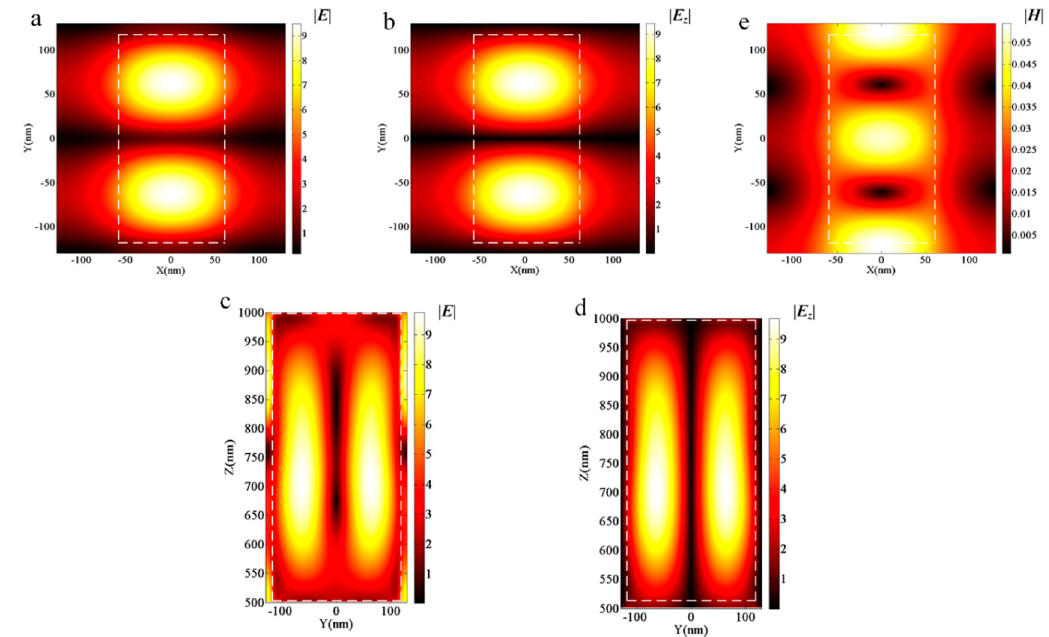
Figure 3. The field distribution of metasurfaces with L x = 120 nm and L y = 235 nm for the y polarized incidence. ( a ) The electric field distribution in the central x – y plane of GaN scatterers. ( b ) The z component distribution of the electric field in the central x – y plane of GaN scatterers. ( c ) The electric field distribution in the y – z plane, x = 0. ( d ) The z component distribution of the electric field in the y – z plane, x = 0. ( e ) The magnetic field distribution in the central x – y plane of GaN scatterers.